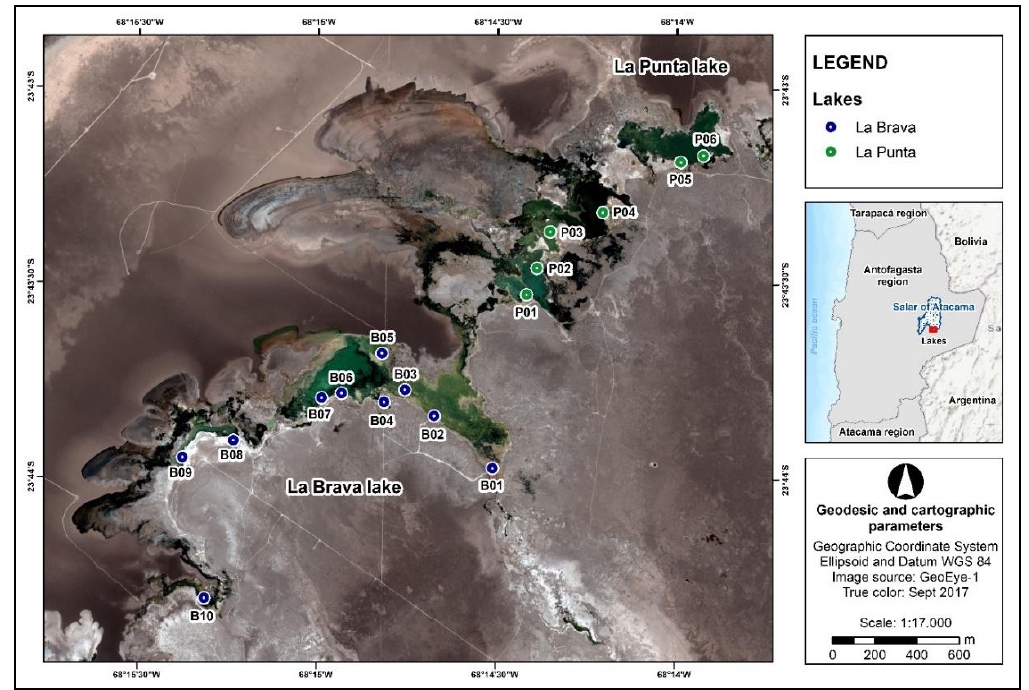
Figure 1. La Brava-La Punta lake system. Ten sampling points for La Brava (B points) and six for La Punta (P points) were defined according to accessibility and ecological dynamics observed in the place. Sampling points of La Brava lake are in blue (B01 to B10). Sampling points of La Punta lake in green (P01 to